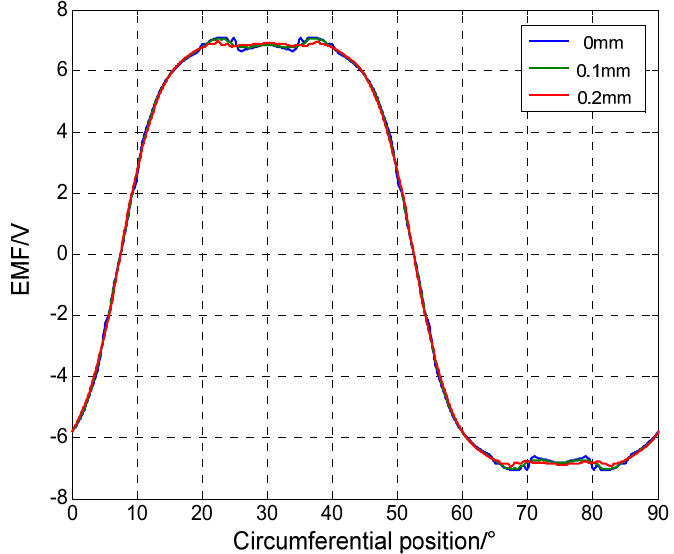
Figure 13. Comparison of EMF waveforms without skew in a variable period.